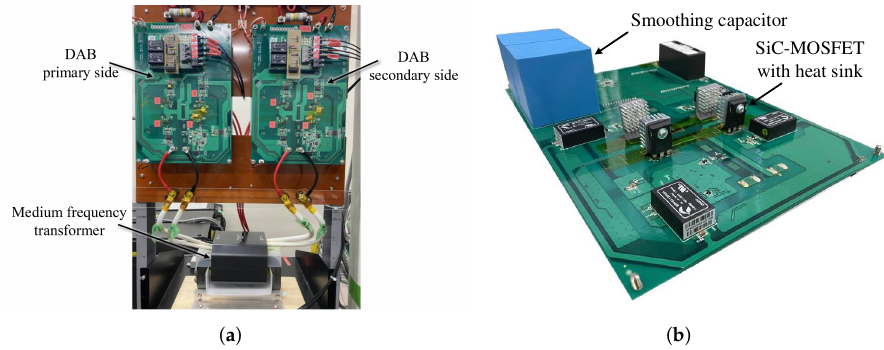
Figure 7. Overview of ( a ) fabricated 4 kW experimental setup and ( b ) back side of the single DAB board.